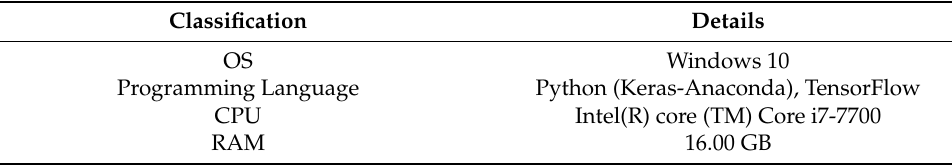
Table 1. Parameters of experimental environment.